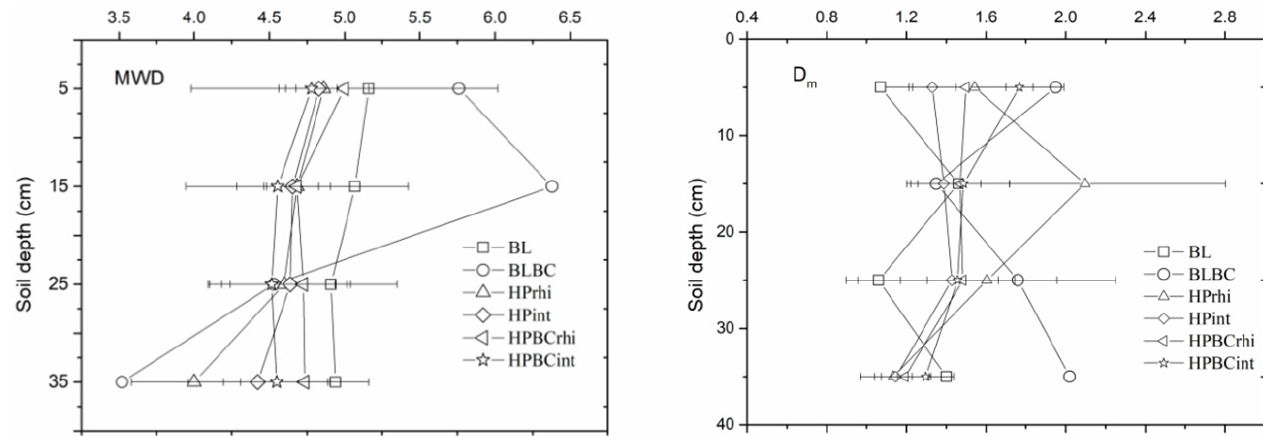
Figure 2. MWD and D m (Mean ± standard deviation) at each depth in experimental plots. Note: MWD—mean weight diameter; D m —fractal dimension of mass; BL—bare land treatment; BLBC— bare land with biochar; HP rhi - planted location in honeysuckle planting treatment; HP int -inter- row location in honeysuckle planting treatment; HPBC rhi - planted location in honeysuckle plant- ing plus biochar addition plot; HPBC int - inter-row location in honeysuckle planting plus biochar addition